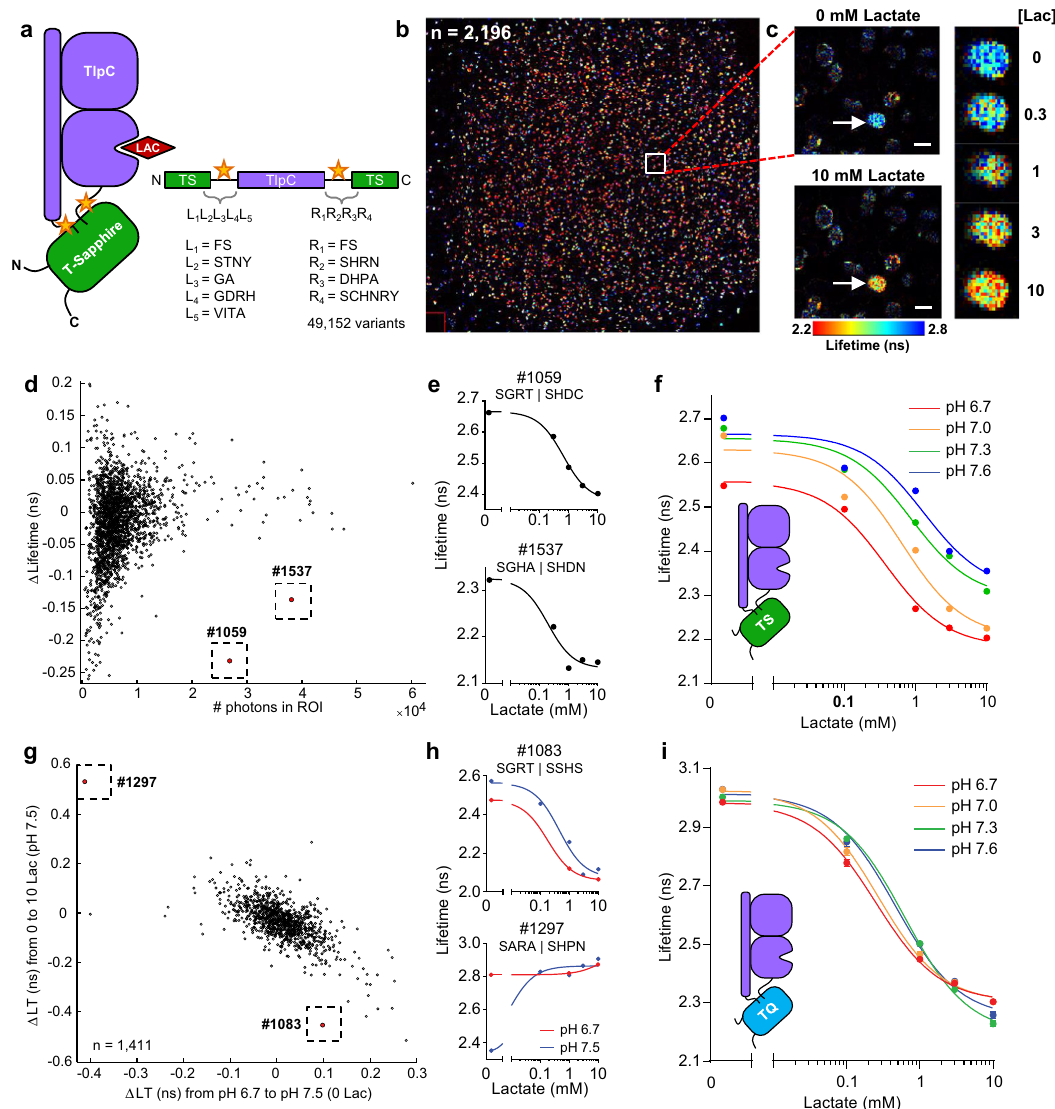
Fig. 3 Development and optimization of a high-performance lifetime sensor for lactate using BeadScan. a Schematic of the lactate biosensor design. The lactate-binding domain of the TlpC protein was inserted into the fl uorescent protein, T-Sapphire. The fl exible linker regions (yellow stars) connecting the two domains were varied in a large biosensor library, sampling 49,152 biosensor variants. b ~10,000 GSBs containing the TlpC-TS lactate biosensor library were immobilized on a 1-cm 2 glass coverslip inside a perfusion chamber. 2196 GSBs met the minimal fl uorescence threshold for ROI detection. The stitched image is recreated from 121 individual frames recorded using 2p-FLIM. The white box marks a single frame (771 μ m square). c One frame showing a single GSB (arrow) containing a biosensor variant that responded well to lactate. The biosensor displayed high fl uorescence lifetime at low [lactate] and low lifetime at high [lactate]. Lifetime values are pseudocolored according to the heatmap at the bottom. Scale bars indicate 100 μ m. d Initial screen of the TlpC-TS lactate biosensor library, showing data from individual biosensor variants captured in GSBs. Average photon counts within each ROI are plotted against the maximum change in lifetime between 0 and 10 mM lactate; each data point represents a single GSB. Two GSBs with large lifetime changes were selected (dotted boxes). e Dose-response curves from each of the two individual GSBs denoted in ( d ). f Performance of TlpC-TS #1059 at four different pH values. Dose-response curves were collected on a uniform sample of GSBs expressing TlpC-TS #1059 ( n = 96 GSBs, mean ± SD). g Multiparameter screening of a linker library of TlpC-TQ, comparing lifetime changes in response to lactate versus pH for each of 1411 individual GSBs. Despite a general correlation between lactate- and pH-induced responses, rare variants that resisted this trend could be isolated (#1083). h Lactate dose-responses from each of the two individual GSBs denoted in ( g ) at pH 6.7 and pH 7.5. The pH-resistant variant (#1083, top) was renamed LiLac. i LiLac responses to lactate are highly resistant to changes in physiological pH. Data collected at room temperature using a uniform sample of GSBs expressing LiLac ( n = 90 GSBs, mean ± SD). In ( f , i ), some error bars are occluded by the data